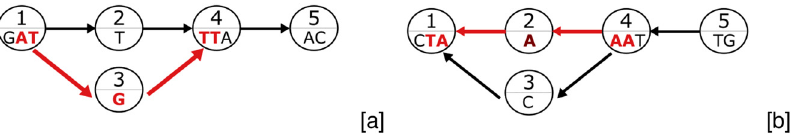
Figure 2: (a) Mapping of the read ‘‘ATGTT’’, which includes an alternative allele of an SNP, on the variation graph in the forward direction; (b) mapping of read ‘‘AAAAT’’, which maps to the reference, on the complemented variation graph in the reverse